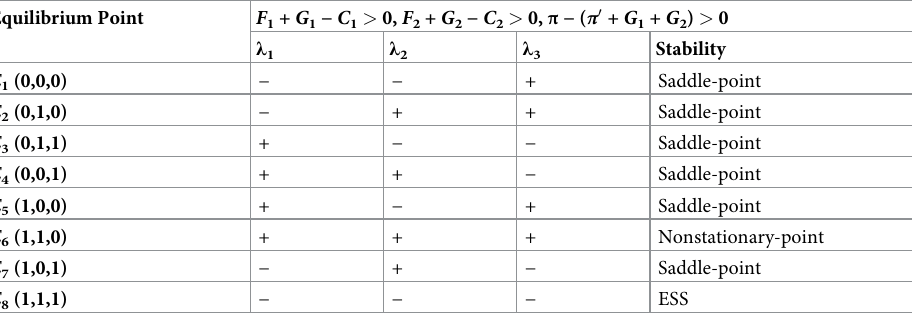
Table 5. Local stability analysis of equilibrium points (Proposition 5). Equilibrium